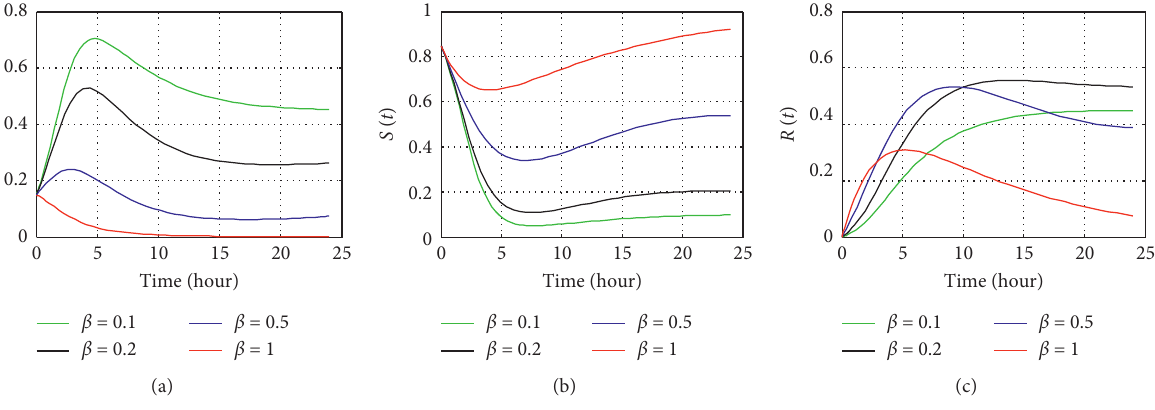
Figure 7: I ( t ) , S ( t ) , and R ( t ) under different β .